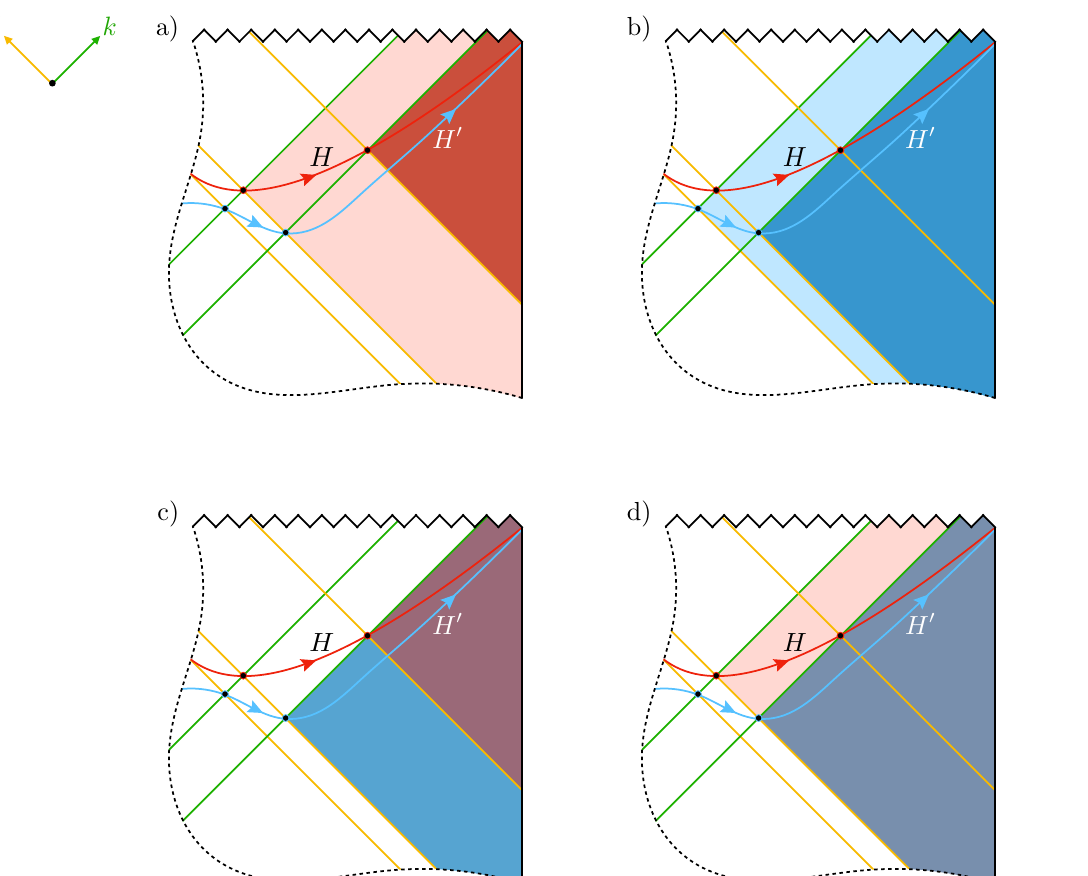
Figure 8 . Generic Penrose diagrams illustrating the relationship between the outer wedges of the holographic screen H (red line) and generalized holographic screen H 0 (blue line), in the spacelike case. In the direction of increasing (cid:28) (arrows), outer wedges of leaves of H are nested, as shown in panel a). Similarly, wedges of H 0 are nested as (cid:28) increases, as shown in panel b). This nesting mandates an increase in outer entropy on H and H 0 . For spacelike screens, each leaf (cid:27) 0 in N k ( (cid:27) ) for some leaf (cid:27) (cid:26) H , leading to the nesting O W ( (cid:27) 0 ) (cid:27) O W ( (cid:27) ) illustrated in panel c). (cid:0) In the case of a generalized holographic screen constructed via intersections as in section 2.4, the opposite nesting also occurs, as shown in panel d). Outer wedges attached to leaves on H ( H 0 ) are shown in translucent red (respectively, blue), with darker shades indicating increasing (cid:28)